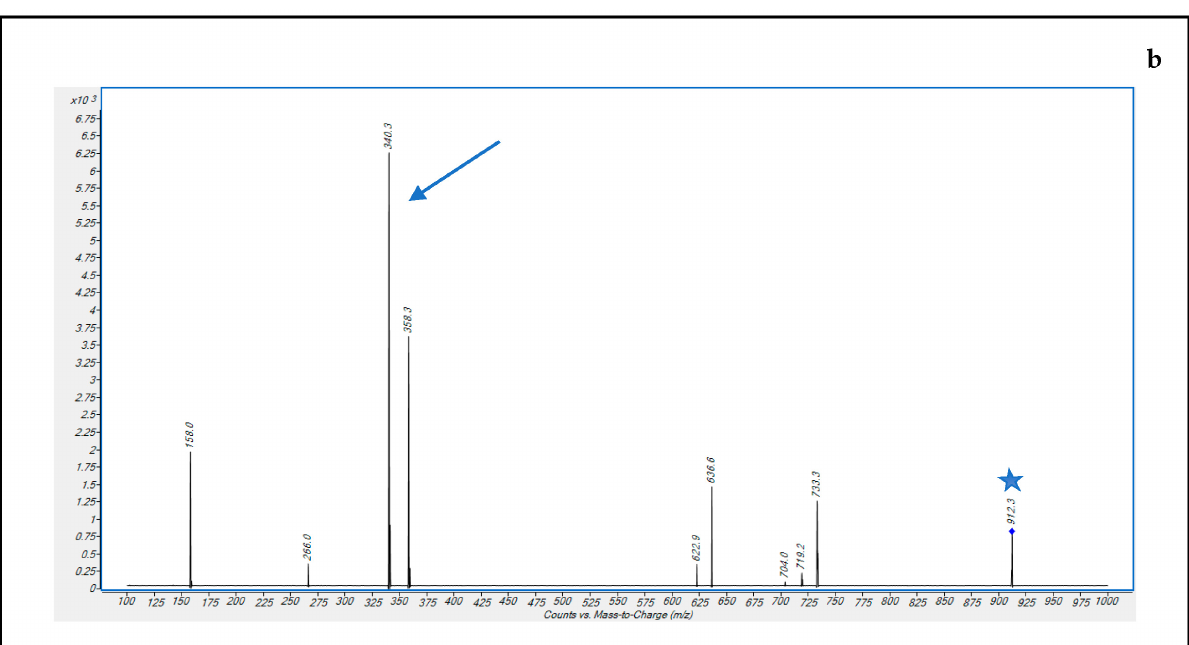
Figure 3. MS/MS fragmentation pattern spectra of DBV ( a ) and DBV-d6 ( b ) Precursor [M + 2H] + 2 ions and product ions selected for MRM transitions are indicated by a blue star and a blue arrow, respectively.